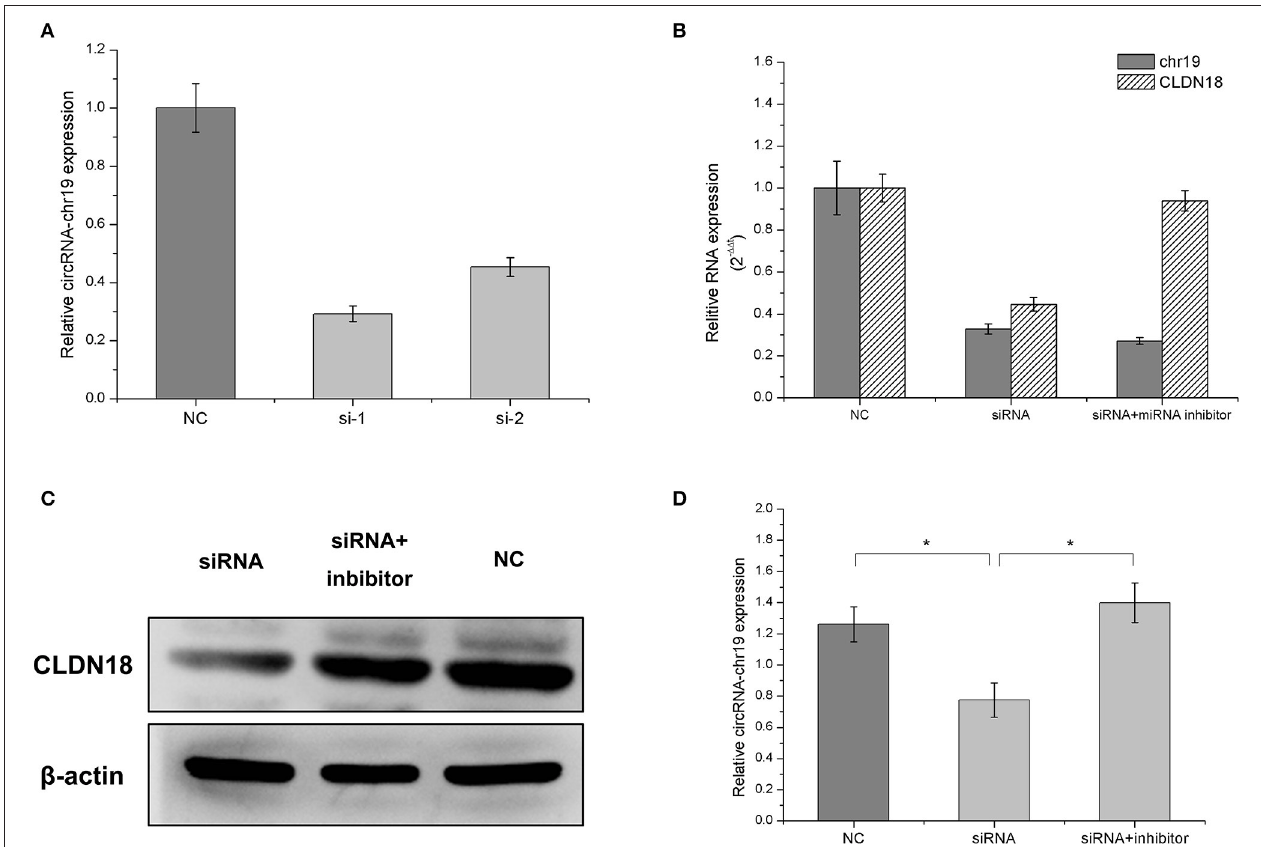
FIGURE 8 | CircRNA-chr19 regulates CLDN18 expression via microRNAs. (A) The best inhibitory effect of small interfering RNAs (siRNAs) against circRNA-chr19 was achieved by si-1, which was analyzed by quantitative polymerase chain reaction (qPCR). GAPDH was used as a control. (B) The regulatory effect of knockdown of circRNA-chr19 by si-1 was destroyed by co-transfection with si-1 and an miR-30b-3p inhibitor. GAPDH was used as a control. (C) The protein expression levels of CLDN18 were analyzed by western blotting. β -Actin was used as a control. (D) The intensities of the respective images in (C) were quantified using Image J software. The results are represented as the mean ± SD of 3 different preparations, * P <